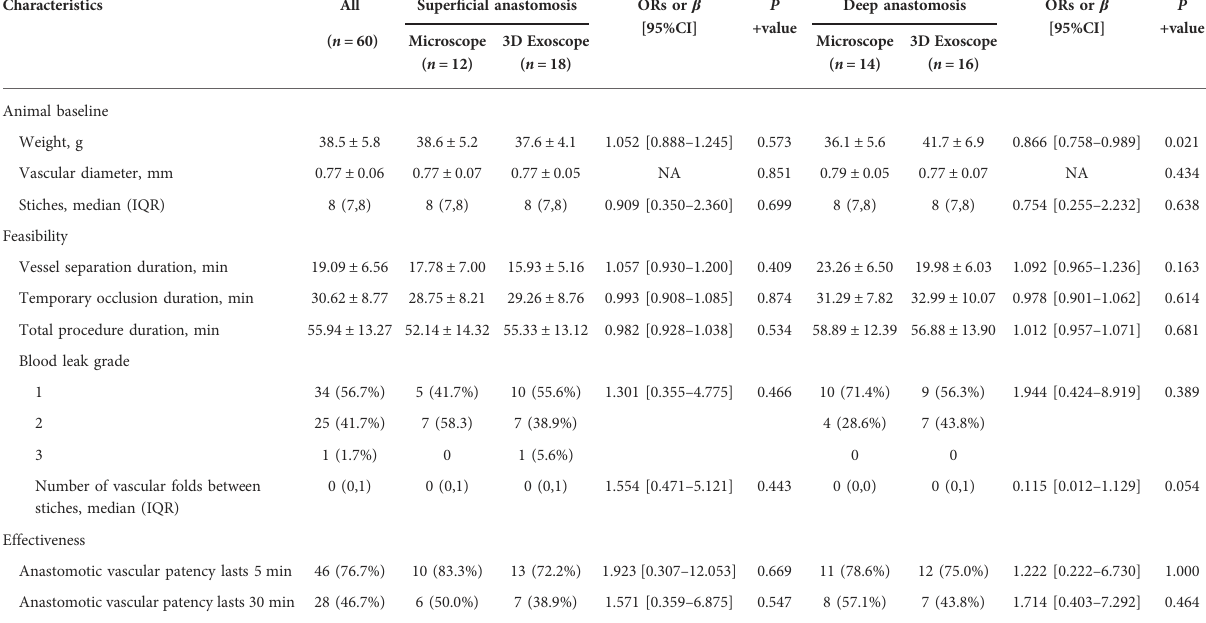
TABLE 2 Characteristics of different experimental